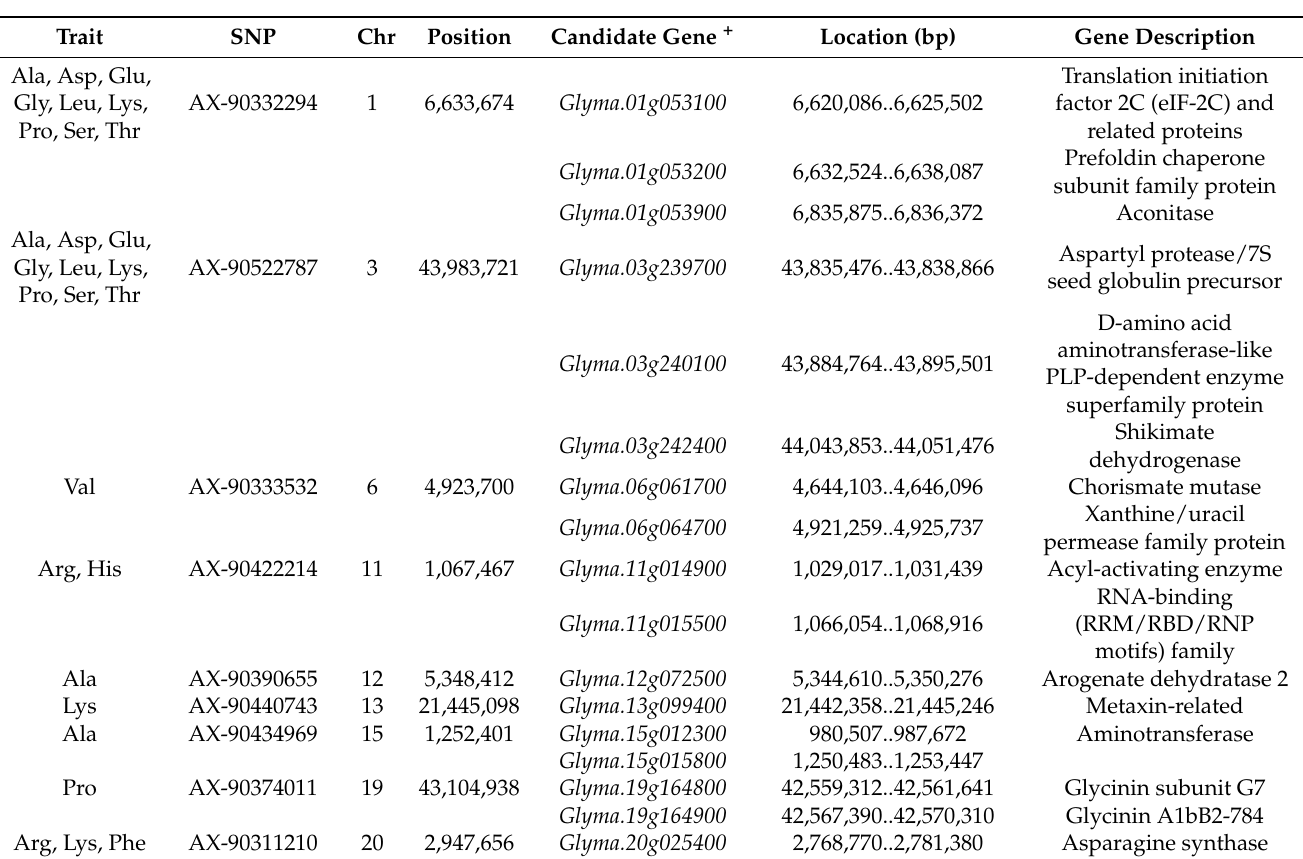
Table 6. Candidate genes associated with amino acid contents in wild